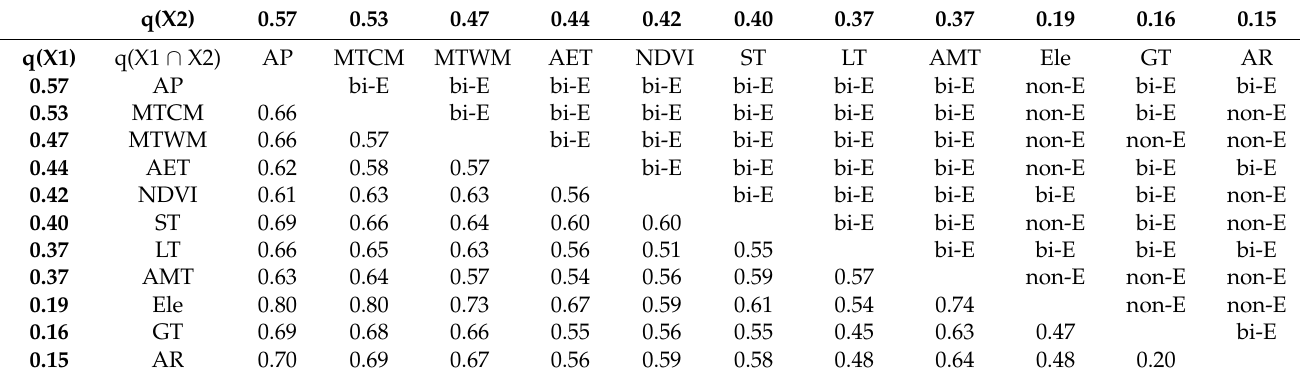
Table 2. Interaction of pairs of environmental factors (q values) on species